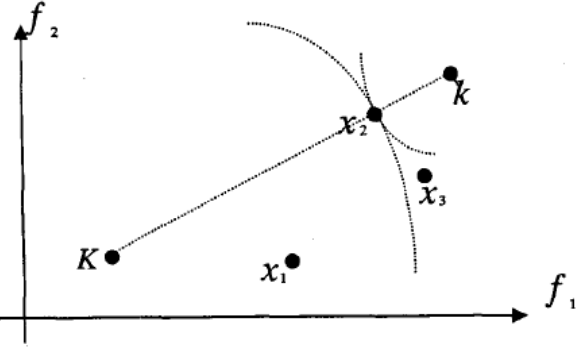
Figure 1. Distance in 2D metric space.